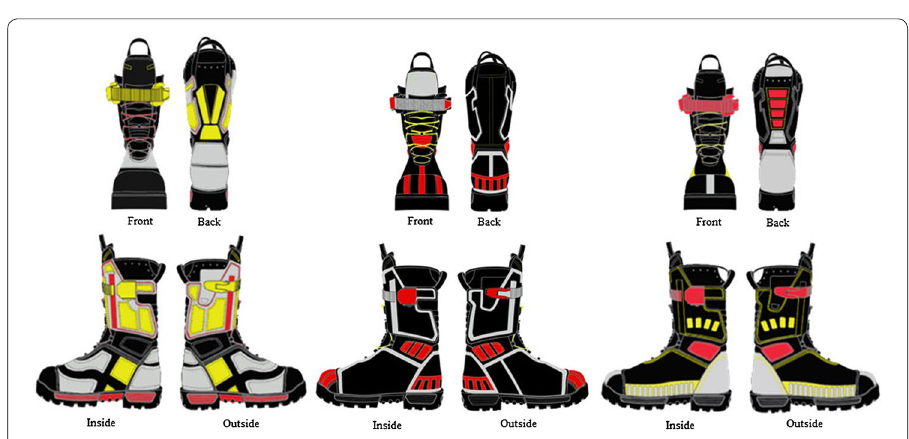
Fig. 2 Design proposal of protective footwear for